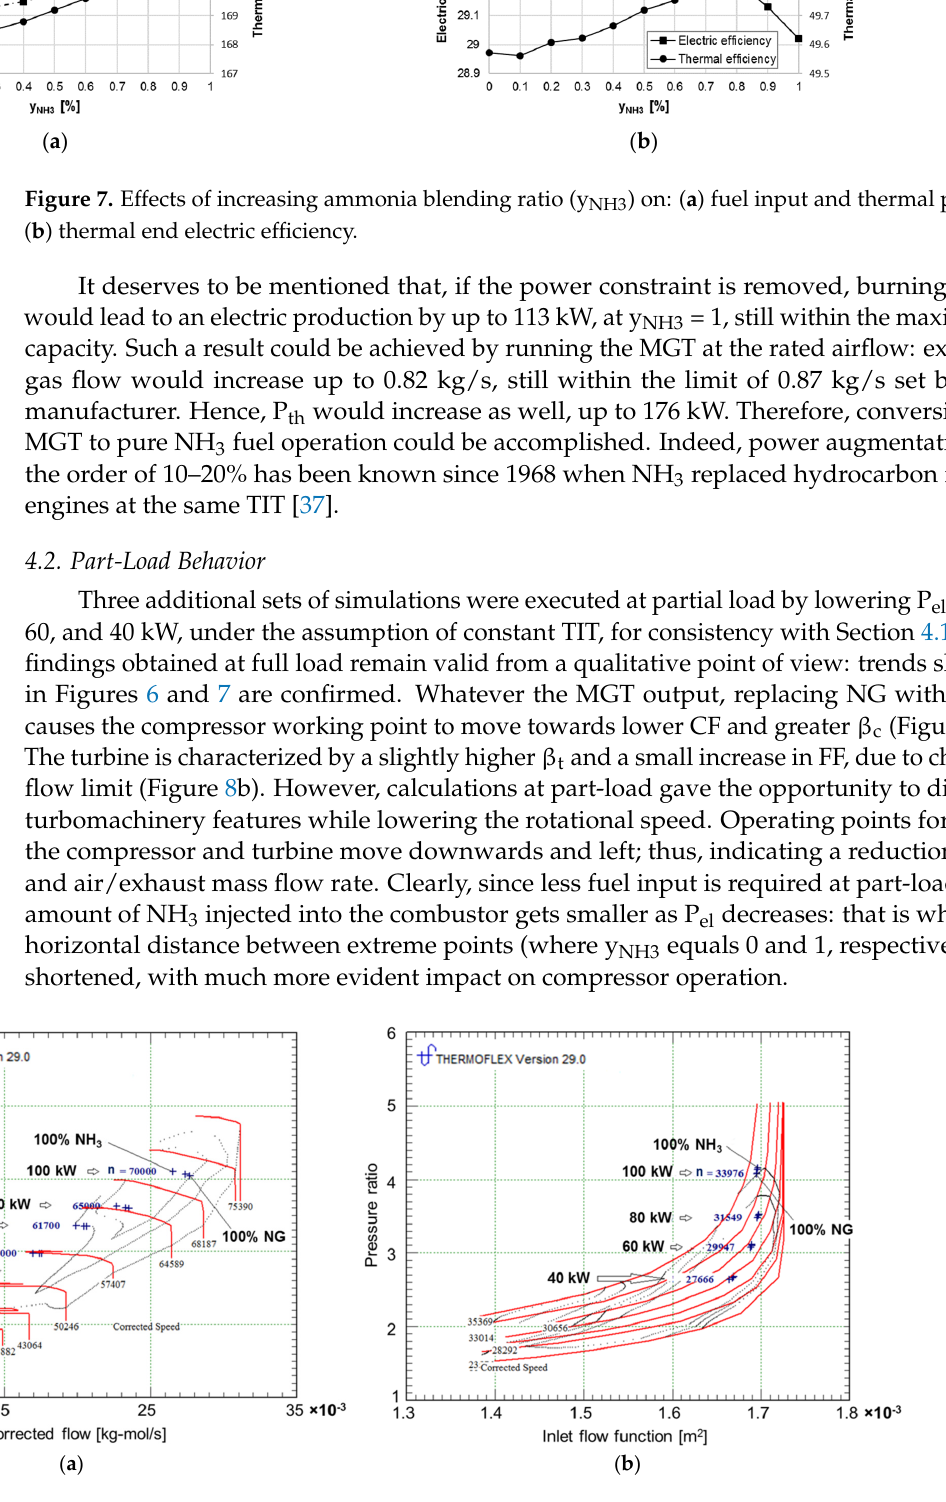
Figure 8. Effects of NH 3 feeding, at different levels of power output, on performance maps of: ( a ) compressor; ( b ) turbine.